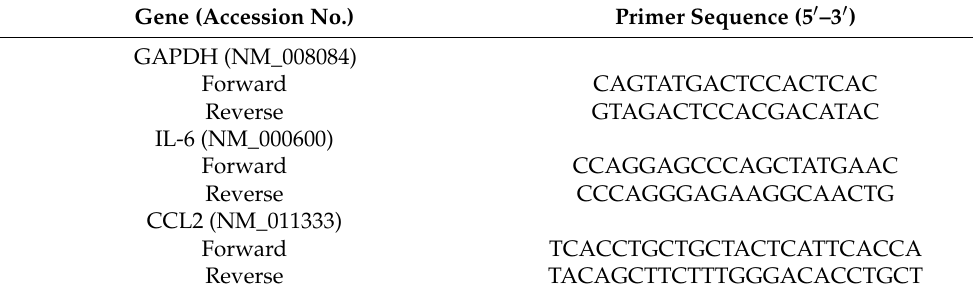
Table 1. Primer sequences used for